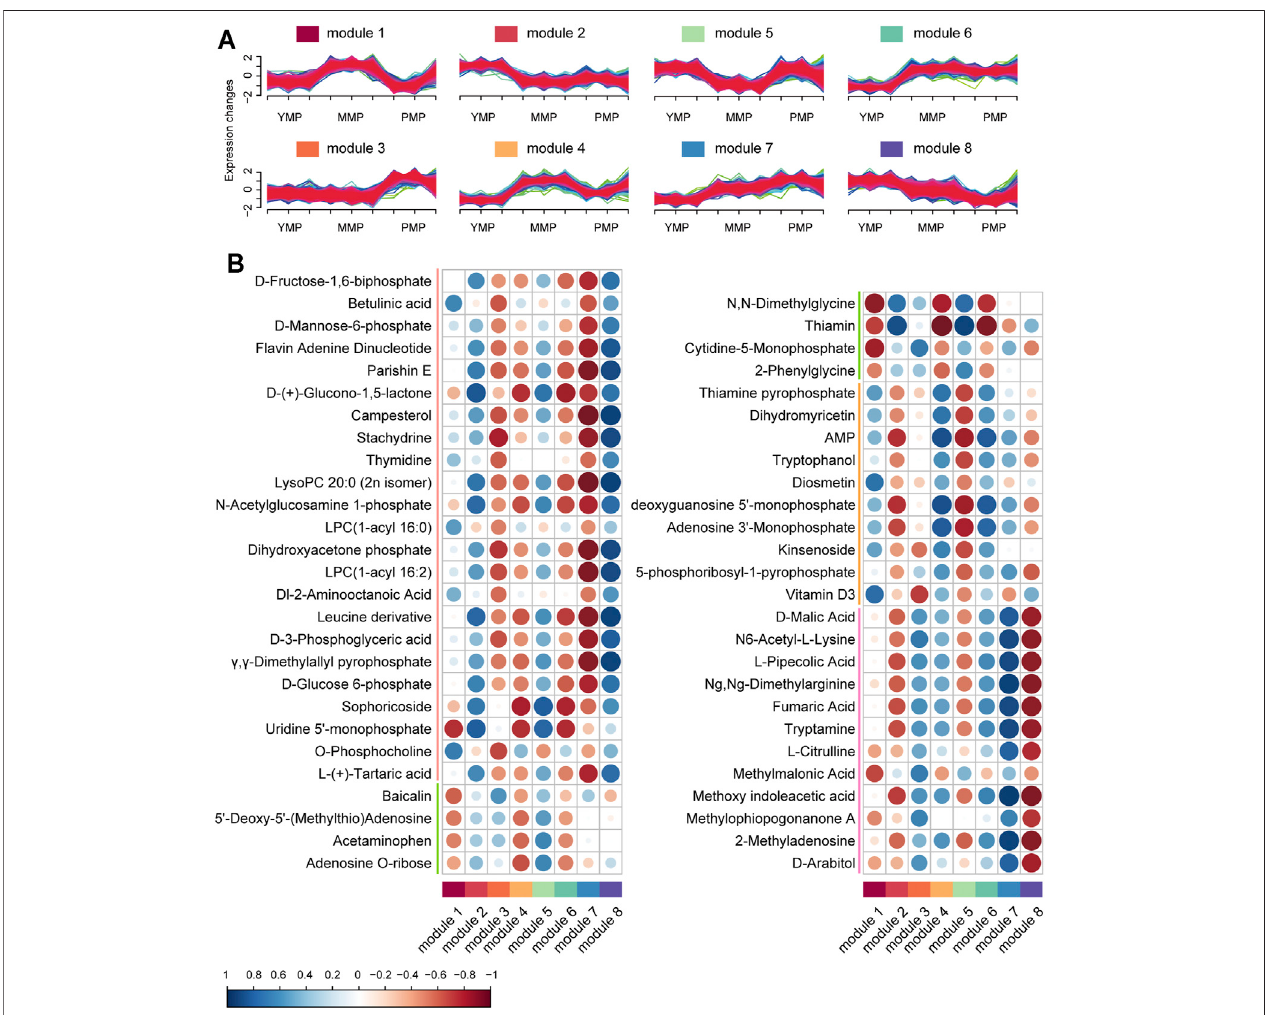
FIGURE 3 | Joint analysis of dynamic changes in growth-dependent metabolites. (A) Modules of differentially expressed genes during the three growth stages of M. sextelata , as obtained using fuzzy c-means clustering. (B) Bubble map showing the module – metabolite correlations. The blue and red colors indicate positive and negative correlations, respectively. Each column corresponds to a module indicated by different